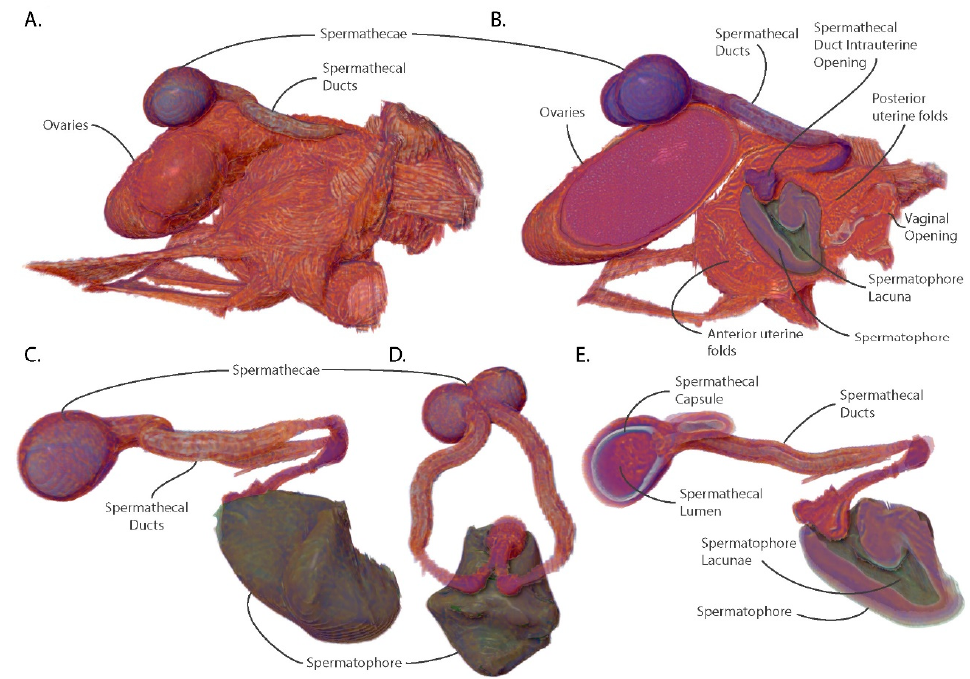
Figure 4. Views of the spermathecae, spermathecal ducts and spermatophore with uterus and ovaries for context. ( A ) Lateral view of uterus, ovaries and spermatheca; ( B ) Sagittal section of the uterus, ovaries, spermatheca and spermatophore; ( C ) Lateral view of isolated spermatheca and spermatophore; ( D ) Anterior view of isolated spermatheca and spermatophore; ( E ) Sagittal section of spermathecae and spermatophore.